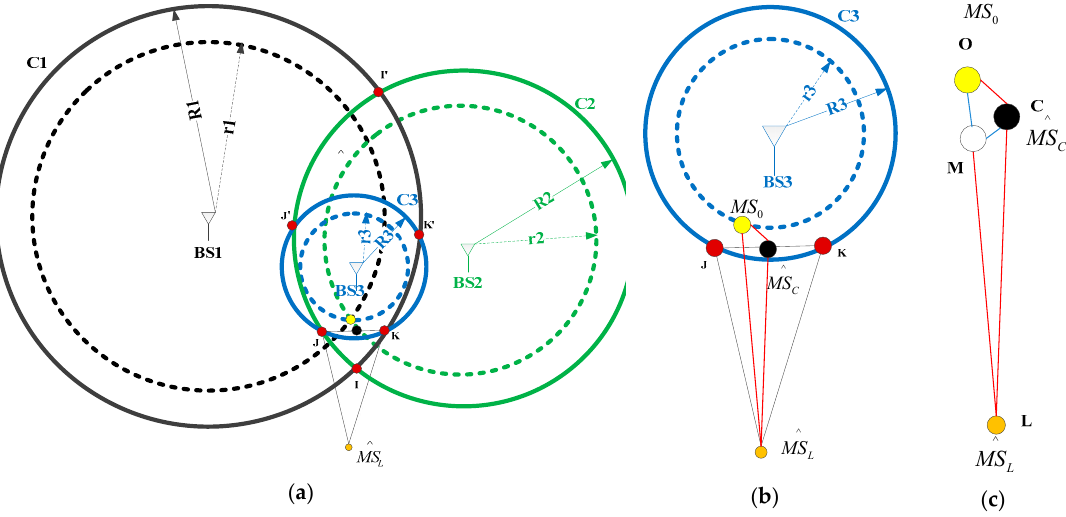
Figure 5. ( a ) Comparison of the original circles and the extended circles. ( b ) Enlarged version focusing on the small circle. ( c ) Triangle formed by the three points of the original MS location and the estimated two locations of the advanced TOA trilateration algorithms.